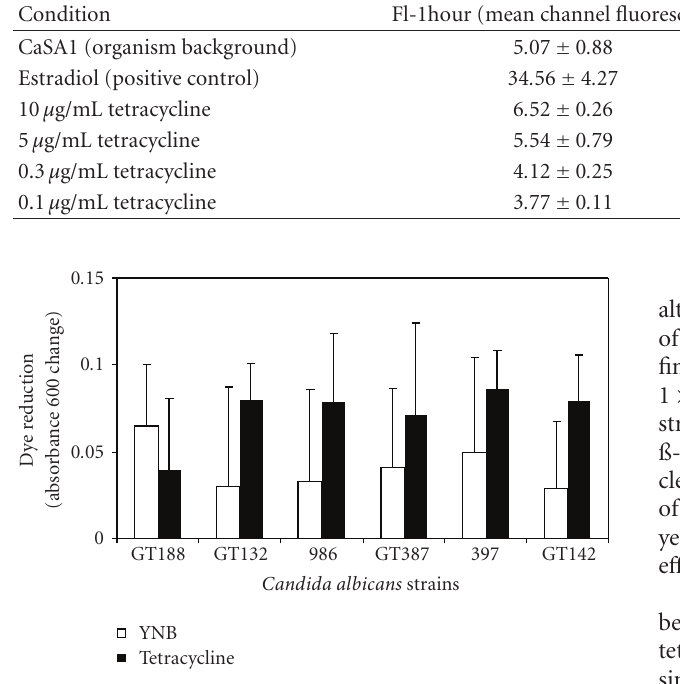
Figure 4: Biofilm was produced in the YNB growth media with or without the addition of tetracycline (0.1 μ g/mL). Biofilm was measured by allowing the metabolic indicator Alimar Blue to be reduced by the biomass remaining after vigorous washing of the wells. The relative biofilm measure represents the dye reduction over a 2-hour period measured at 600 nm spectrophotometrically. Of note, 5 of the 6 strains tested showed a tendency toward increased biofilm metabolic activity when exposed to tetracycline, though the variability of the biological assay limited definite conclusions regarding excess biofilm production.